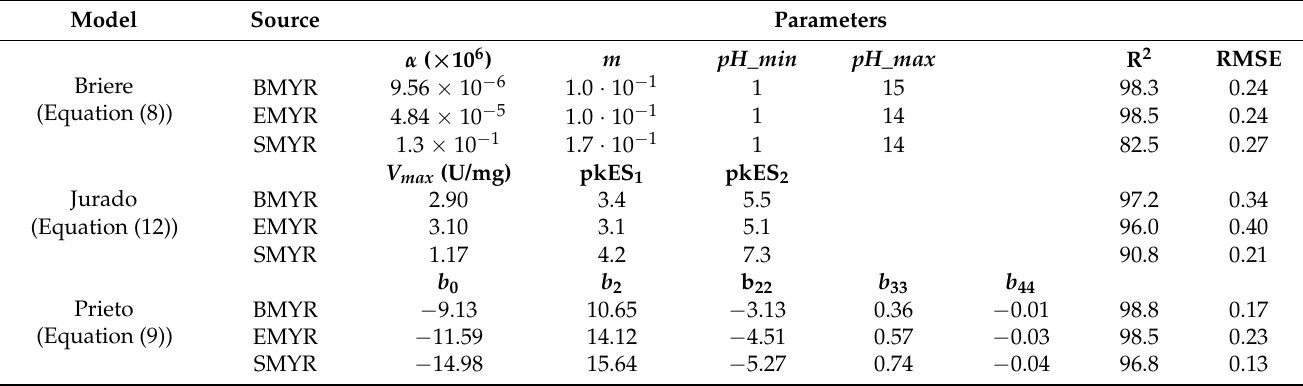
Table 5. Adjustment of pH-dependent models to myrosinase kinetics.